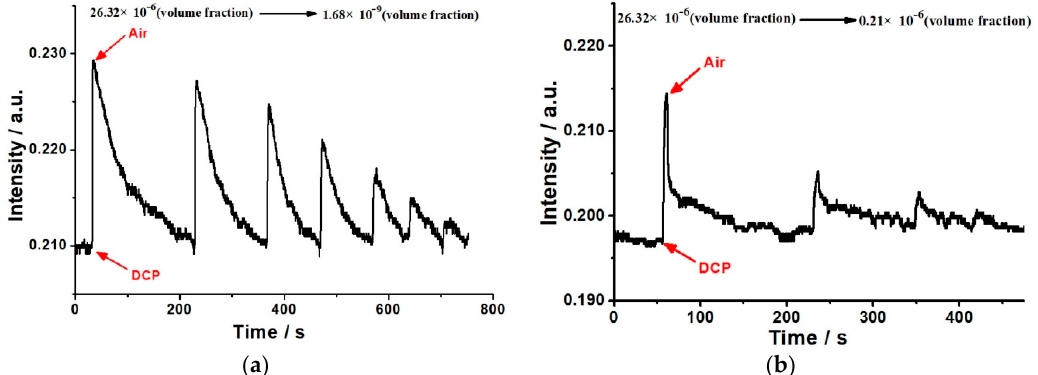
Figure 4. Typical response of CV-SiO 2 gel film coated PIE OWG sensor ( a ) and CV coated PIE OWG sensor ( b ) when exposed to DCP vapor.